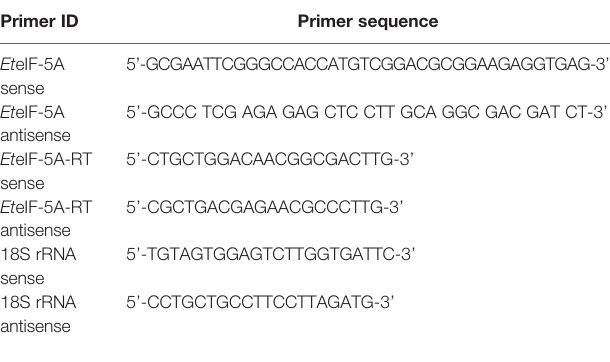
TABLE 1 | Sequences of primers used in this